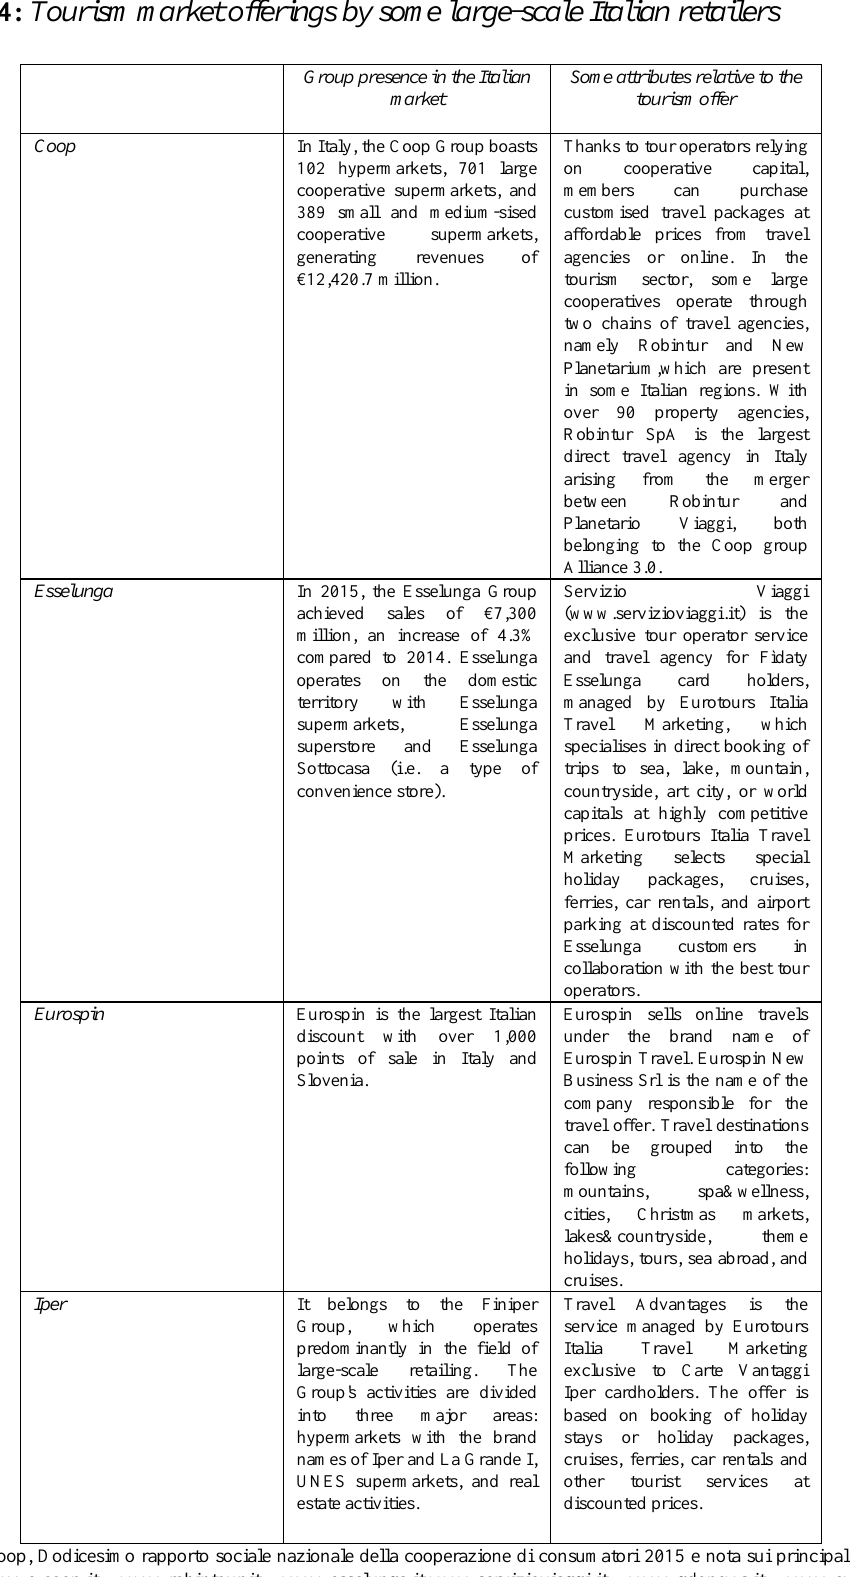
Table 4: Tourism market offerings by some large-scale Italian